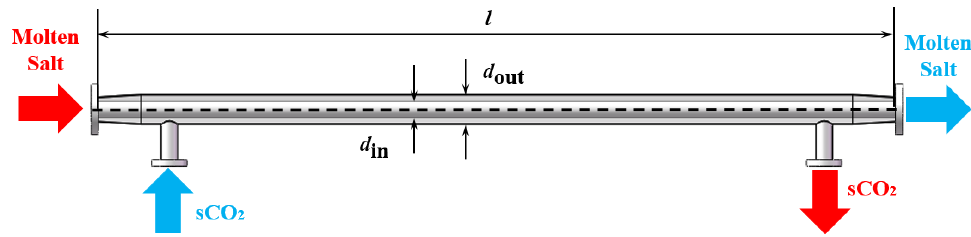
Figure 1. The schematic diagram of the concentric tube heat exchanger.